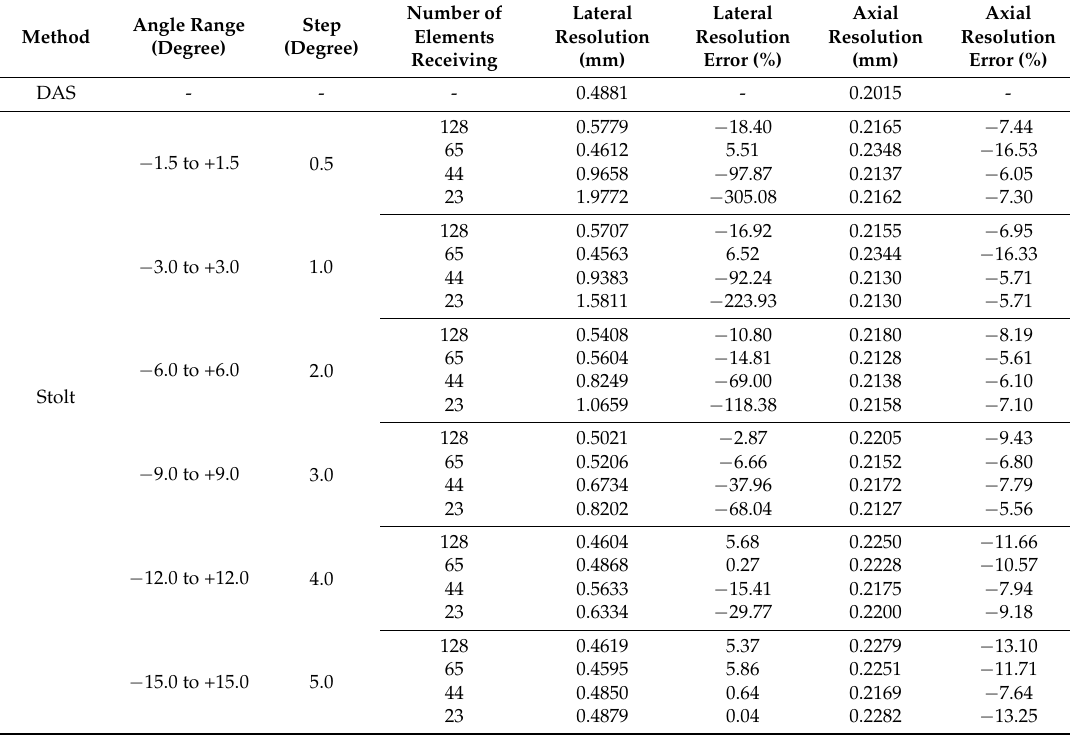
excitation at different angle ranges and receiving with all 128 elements (non-sparse mode) and with 65, 44, and 23 elements (sparse mode). Table 3. FWHM—Lateral and axial resolution analysis and percentage errors for the images of the target located at 2.0 cm in the simulated phantom using the DAS method results as a reference to compare with the Stolt migration method.